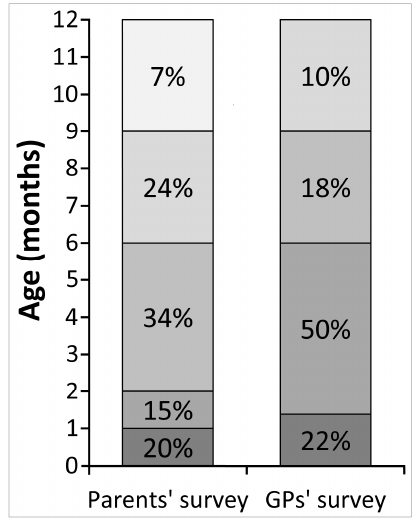
Figure 2. How old the child was during the first appointment with the